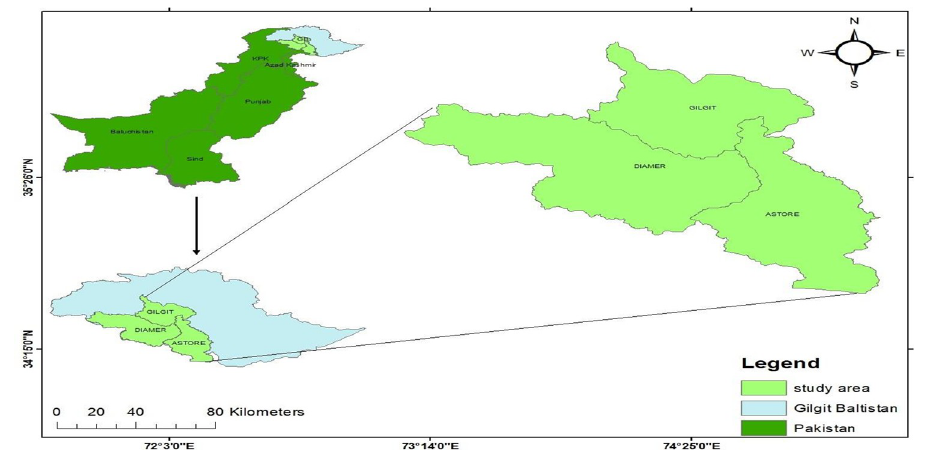
Fig 1. Location map of the study